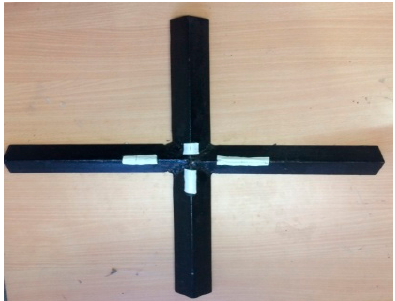
Figure 5. Experimental setup for the fundamental torsional frequency.